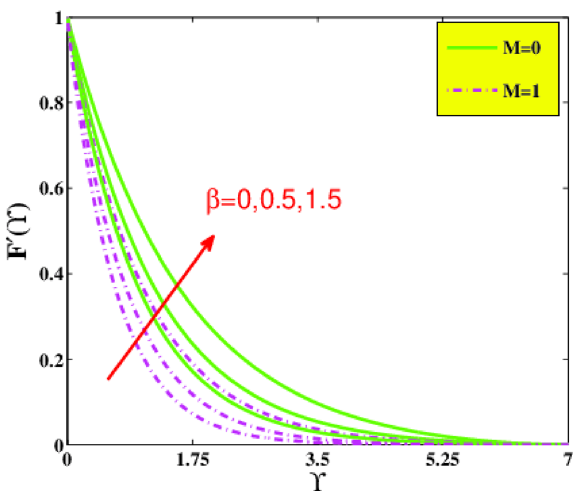
Figure 4. Velocity F ′ (ϒ) via β and M .